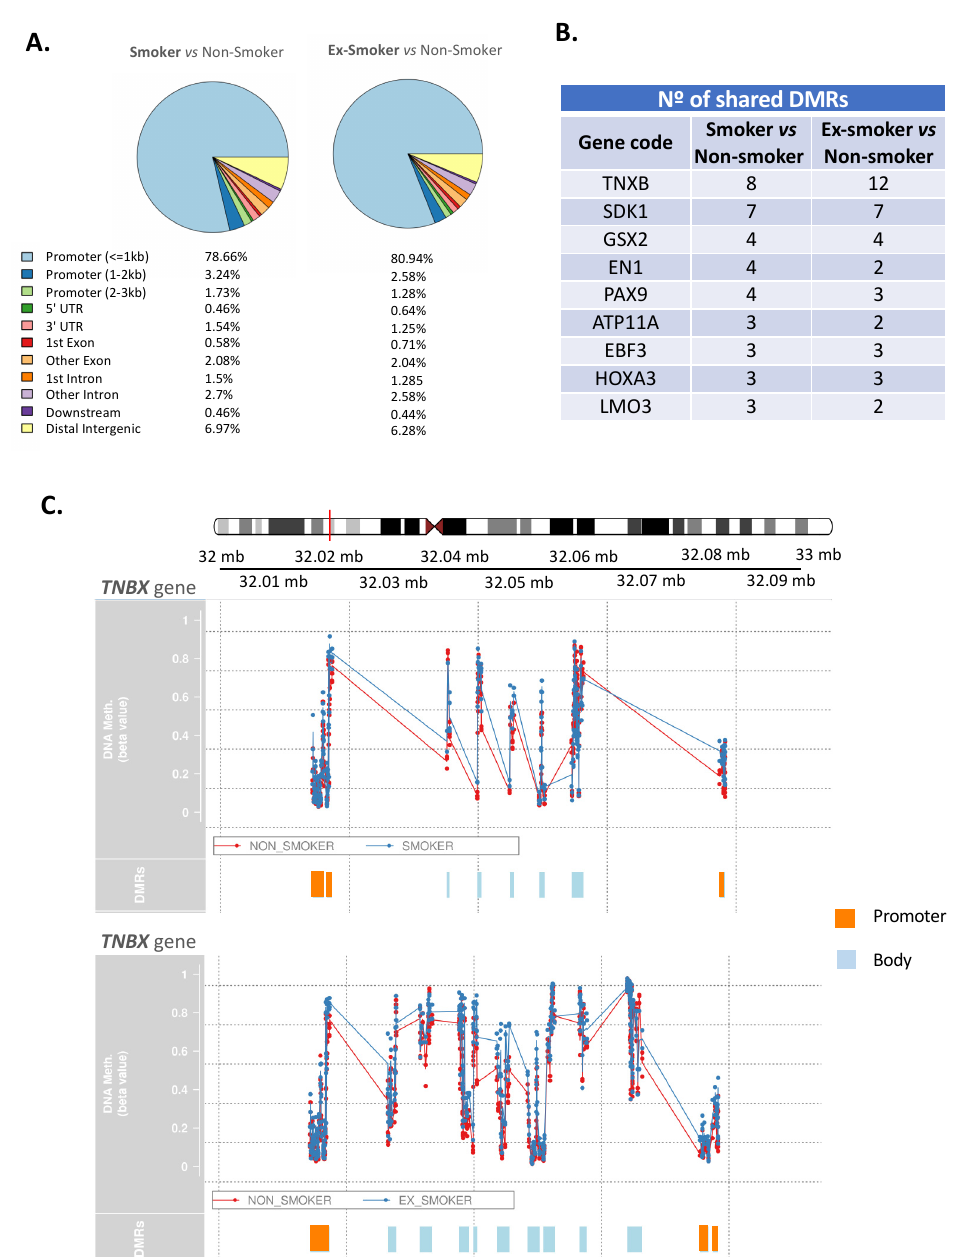
Figure 3. Smoking status revealed notable changes in differentially methylated regions in adipose- derived stem cells from patients with Crohn’s disease. ( A ) Intragenic differentially methylated region (DMR) distribution: 83.63% (smokers versus non-smokers) and 84.8% (ex-smokers versus non-smokers) of the DMRs are located in the promoter region and 15% are in the gene body. ( B ) Table representing genes with more DMRs which are present in both smoker vs. non-smoker and ex- smoker vs. non-smoker groups. ( C ) Signi fi cant DMRs of TNBX gene in the comparison smoker vs. non-smoker (panel above, 8 signi fi cant DMRs) and ex-smoker vs. non-smoker (panel below, 12 sig- ni fi cant DMRs).